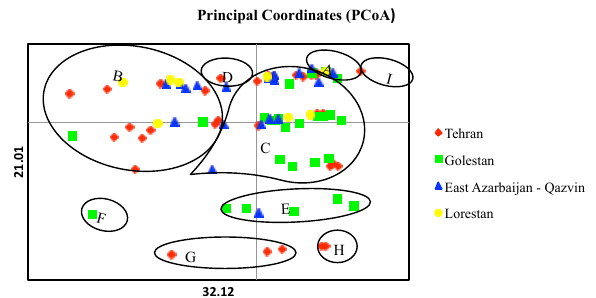
Figure 4. Principal coordinate analysis of 88 isolates among four Fusarium culmorum populations, based on SSR markers.